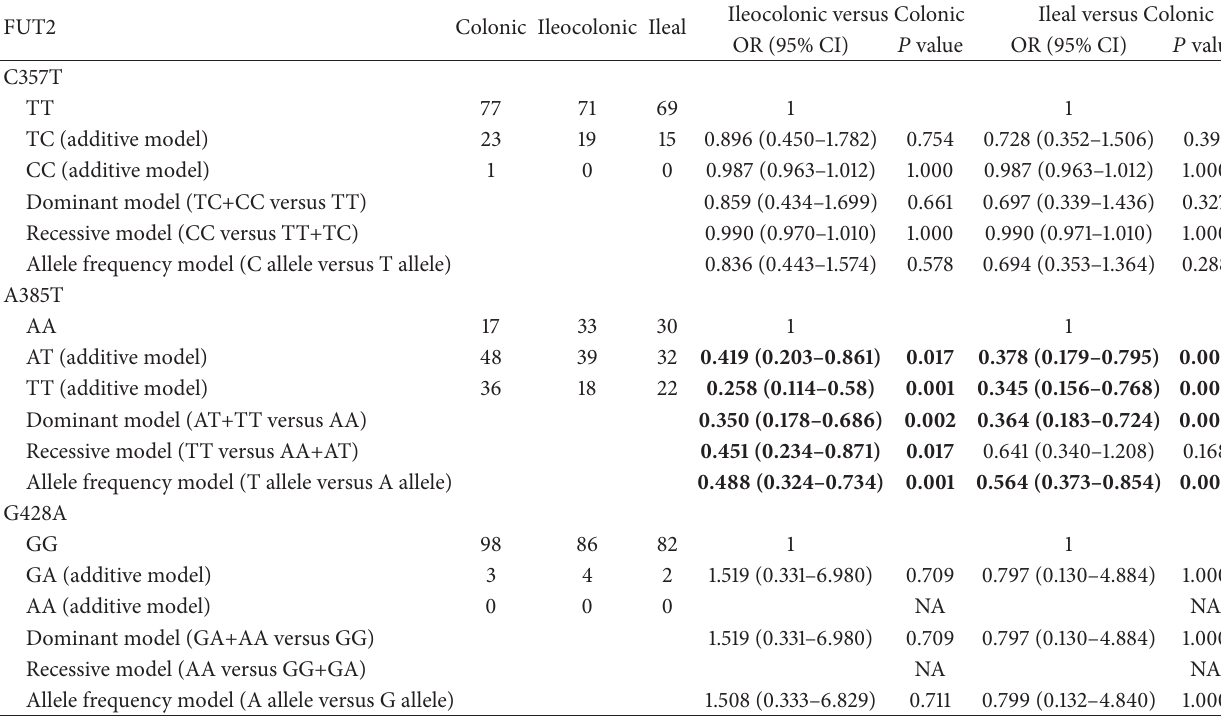
Table 4: Association of FUT2 gene polymorphisms with the location of CD